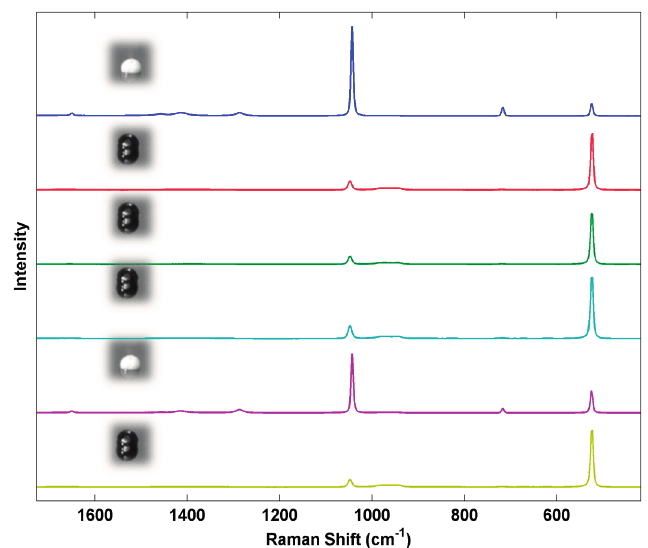
Figure 7. Comparison of Raman spectra of inkjet test materials containing both liquid and solid AN deposits.